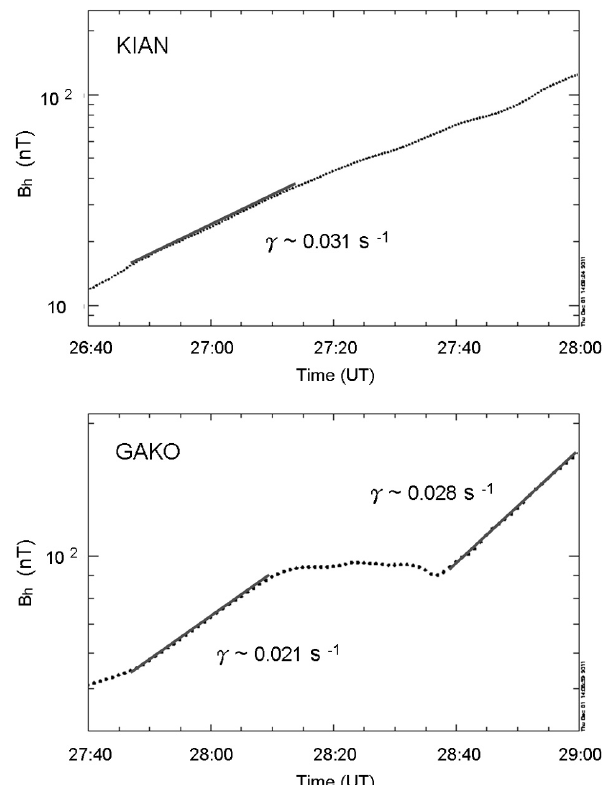
Fig. 8. The growth of the westward electrojet current associated with the arc at KIAN (upper panel) and the arc at GAKO (lower panel), which is proportional to B h (the decrement of the H- component magnetic field relative to the background dipole field) measured by the ground magnetometer underneath the